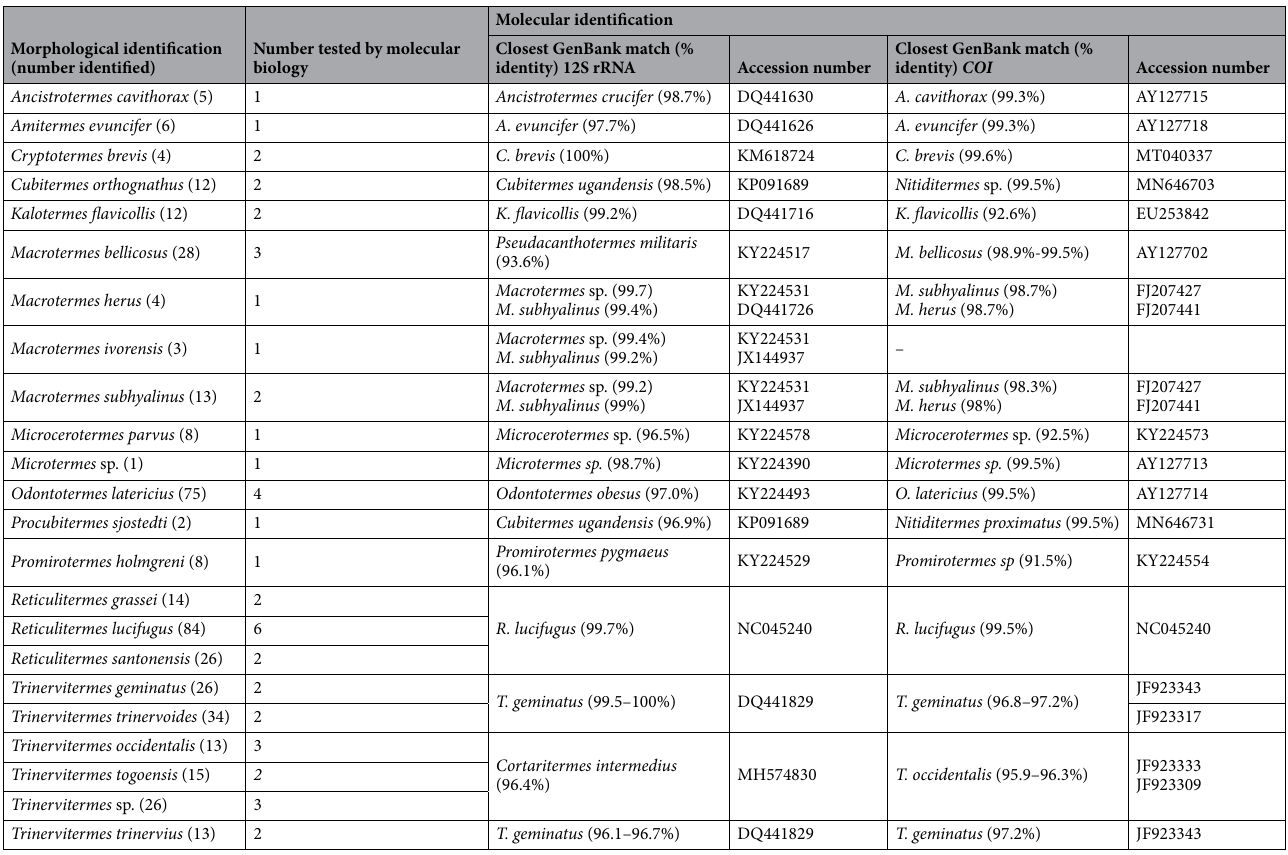
Table 1. Morphological and molecular identification of termites, number of each termite species, number tested by molecular and 12S rRNA and COI accession